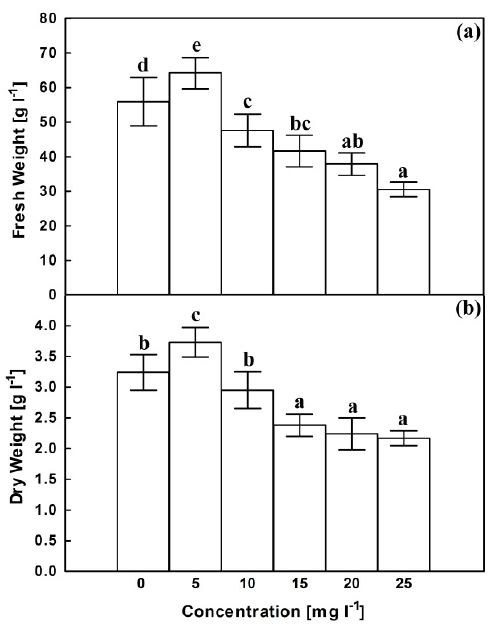
Figure 1. Effects of AgNPs at concentrations of 5, 10, 15, 20 and 25 mg L − 1 on fresh weight ( a ) and dry weight ( b ) of C. roseus cell suspension cultures. Means ± standard deviations (SDs), n = 3, Values followed by the same small letter within each column are not significantly different at p ≤ 0.05.